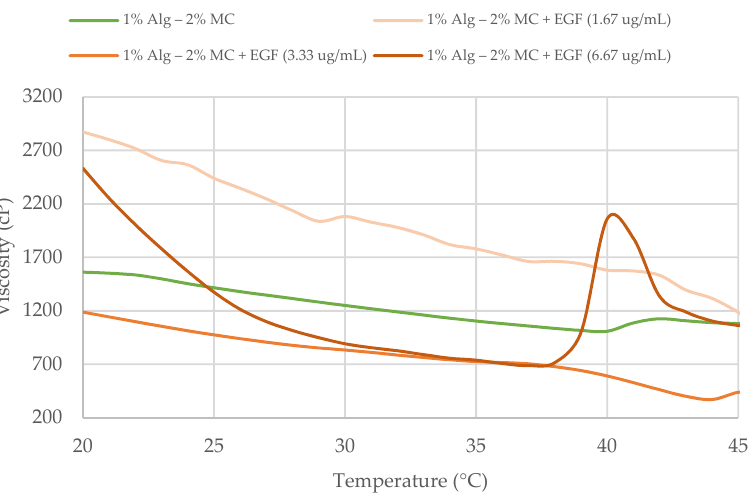
Figure 9. The effect of epidermal growth factor concentration (red) on the viscosity of 1% w/v alginate–2% w/v methylcellulose gel mixture (green) when temperature increased by 1 ◦ C per minute. Viscosity values were continuously acquired as a function of increasing temperature.